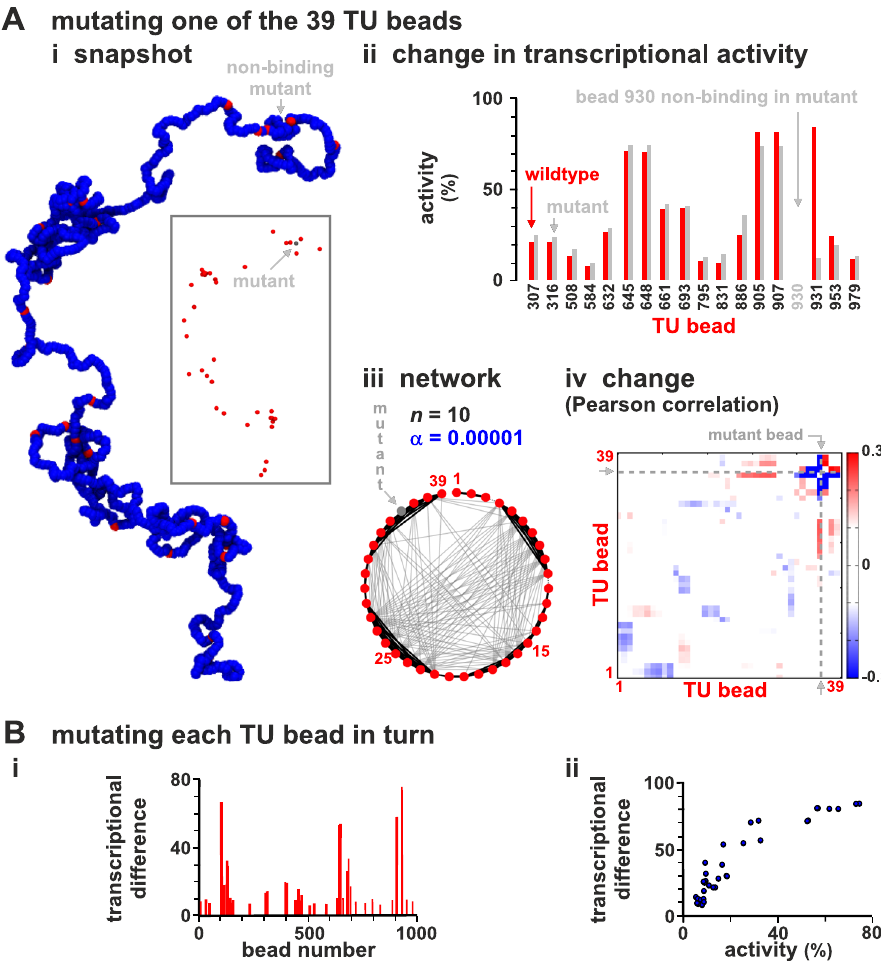
Fig. 4 Modelling SNPs and eQTL action. Sets of simulations ( ≥ 800 simulations/condition) where each of the 39 TU beads is made non-binding in turn (to represent 39 different SNPs in regulatory elements) are compared with those with the "wild-type'' chain (as Fig. 1). A Chain with mutant (non-binding) TU bead 930. (i) Snapshot. TFs not shown (inset: same structure without blue beads). (ii) Transcriptional rates of the 17 TUs with signi fi cantly different values in mutant fi bre compared with the wild-type one ( p ≃ 0.046; two-sided Student ’ s t -test). (iii) Regulatory network inferred from the matrix of Pearson correlations between activities of TUs. (iv) Change in Pearson correlation between TUs. B Results from simulations where each TU bead is mutated in turn, and the “ transcriptional difference ” from the wild type (see text and Supplementary Note 2) determined. (i) Transcriptional difference versus position along the chain. (ii) Positive correlation of transcriptional difference with TU activity in wild type. The plot shows that if we mutate a TU with high transcriptional activity, this leads to a larger